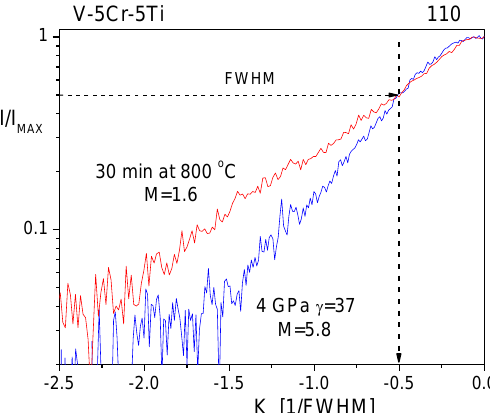
Figure 3. Intensity distributions of the {110} reflections of a V-5Cr-5Ti alloy deformed by high-pressure torsion at 4 GPa pressure to the shear strain of γ = 37 (red curve) and after heating to 800 ◦ C (blue curve) with logarithmic intensity scale normalized to the maximum intensities and the FWHM. More details about material processing and the heat treatments can be found in Reference [40].